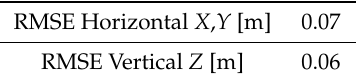
Table 5. Field landing position